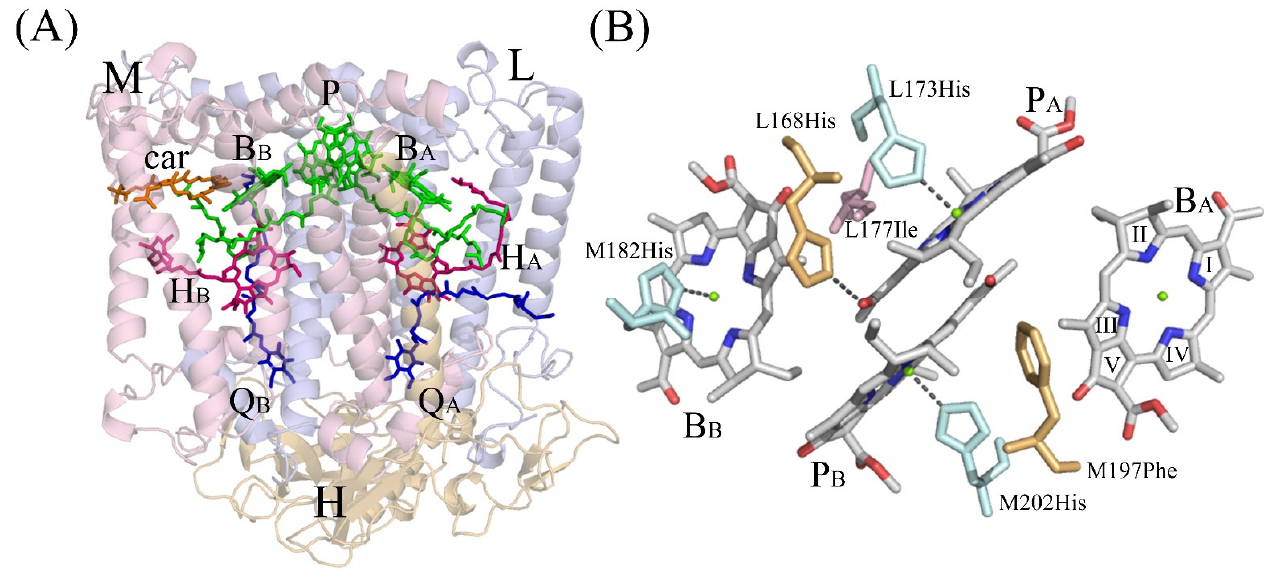
Figure 1. ( A )–The overall structure of the reaction center of C. sphaeroides (PDB ID: 3v3y) and ( B )-protein environment of bacteriochlorophylls. L, M, and H–correspondent RC subunits; P-BChl dimer of P A and P B ; B A and B B -monomeric BChls; H A and H B - monomeric BPheos; Q A and Q B -ubiquinones; car-carotenoid. Shown in pale-blue: His-M182, His-L173, and His-M202- ligands of BChls B B , P A, and P B , correspondently. Symmetry related residues His-L168 and Phe-M197 are shown in pale-yellow, Ile-L177 is shown in light-pink. Pyrrole rings numbers are shown on the structure of BChl B A .